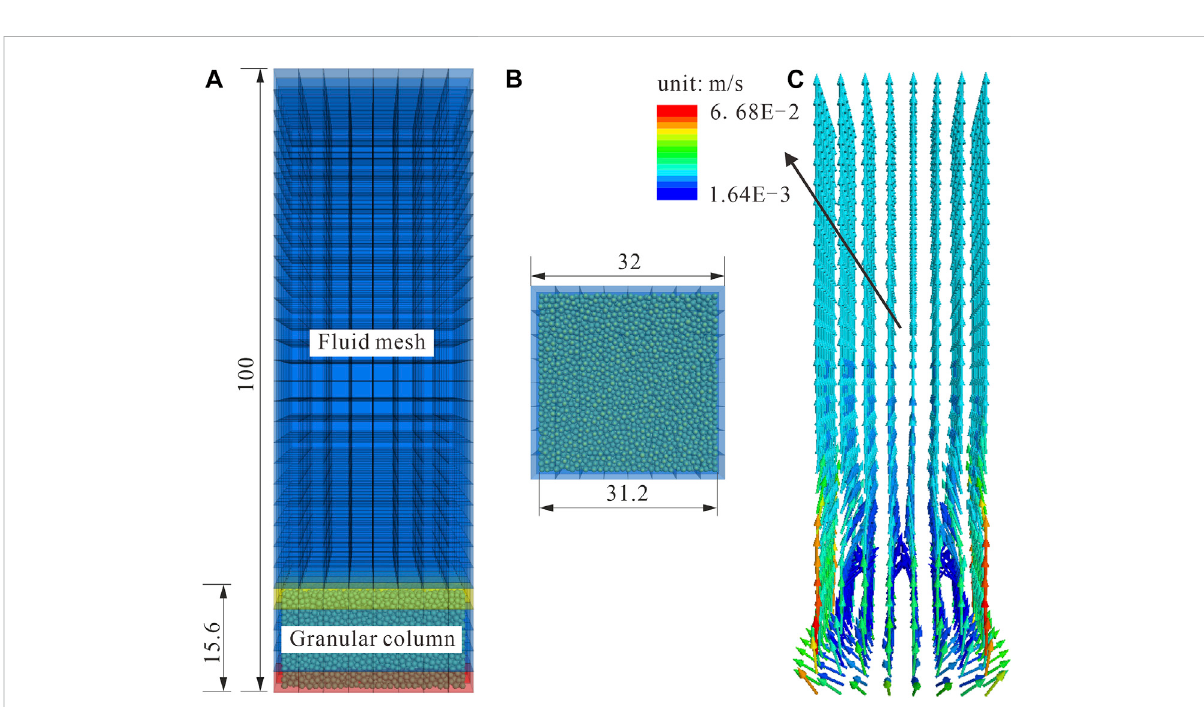
FIGURE 2 Ergun test model (unit: mm): (A) front view; (B) bottom view; and (C) fl uid velocity